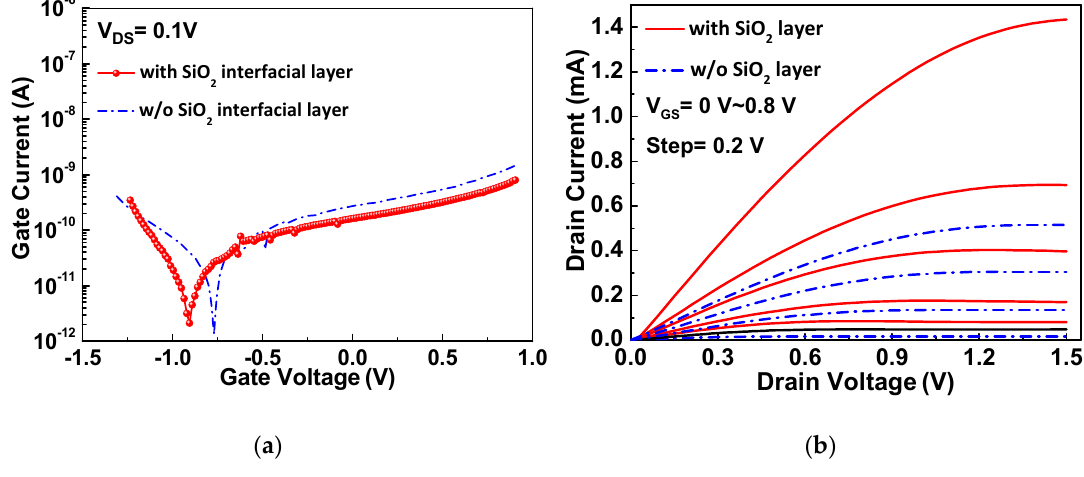
Figure 2. ( a ) I GS -V GS and ( b ) I DS -V DS characteristics of the top-gate SnO 2 with and without an SiO 2 interfacial layer.